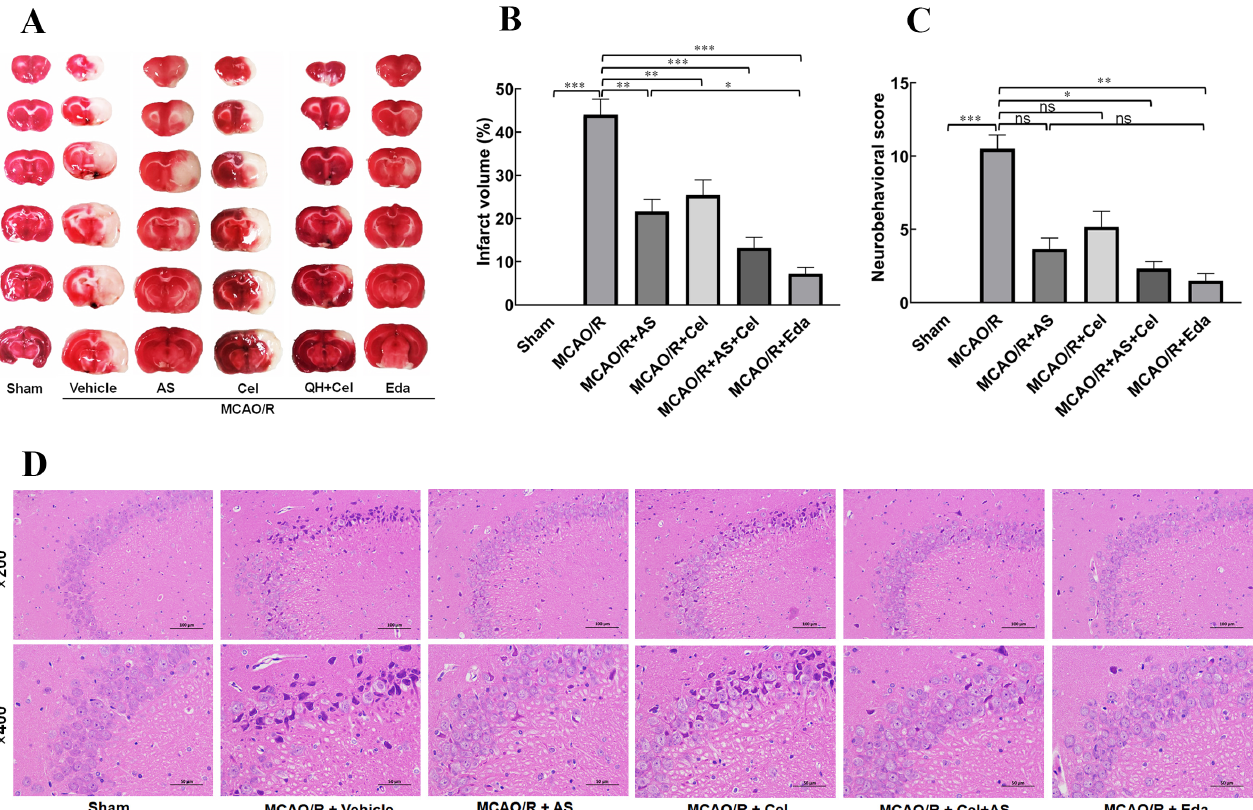
Figure 3. AS treatment improved CIRI in MCAO/R rats. ( A ) TTC staining was performed to evaluate infarct volume. ( B ) The infarct volumes of different groups were calculated. (n = 6 rats for each group) ( C ) Neurobehavioral deficits were detected by mNSS scoring at 14 d after reperfusion. (n = 6 rats for each group) ( D ) HE staining revealed the pathological morphology. (n = 3 rats for each group). Data are expressed as the mean ± SD, * p < 0.05; ** p < 0.01; *** p < 0.001; ns stands for no statistical significance.